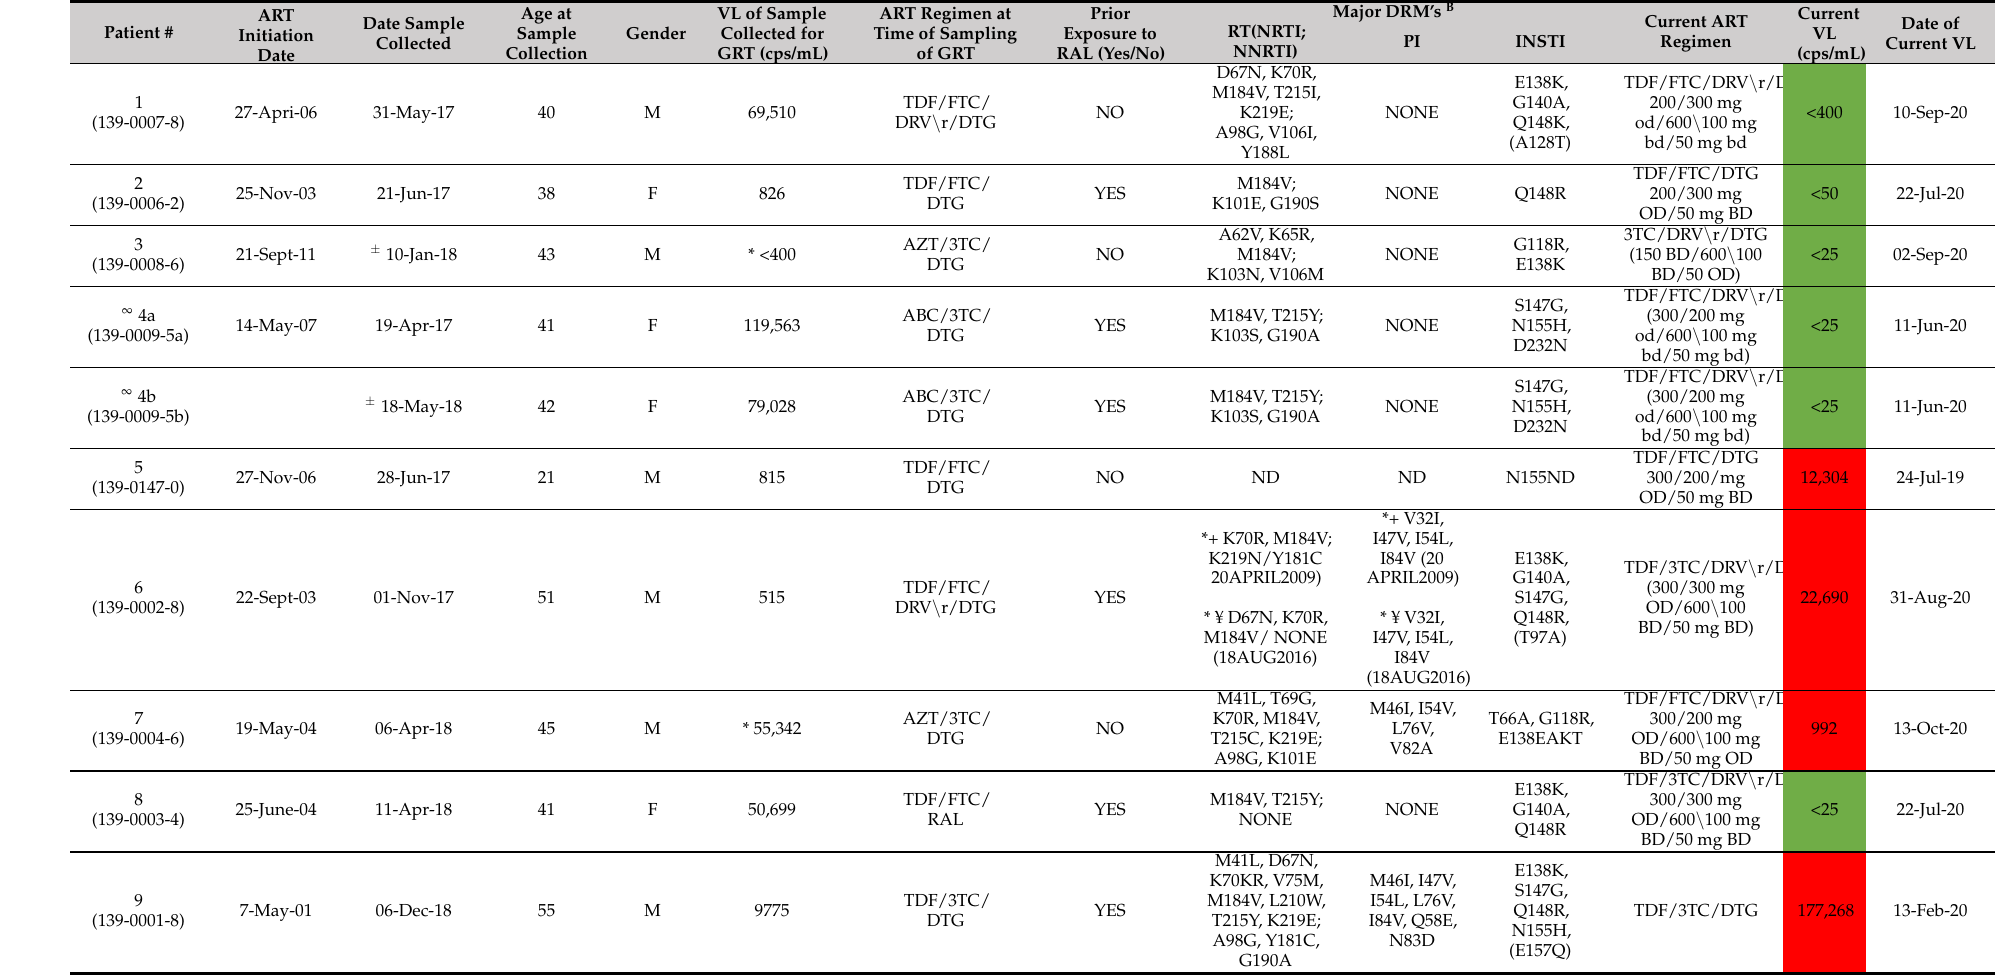
Table 2. Demographics, viral loads, cART regimens and DRM’s of 11 individuals with multi-class drug resistance in